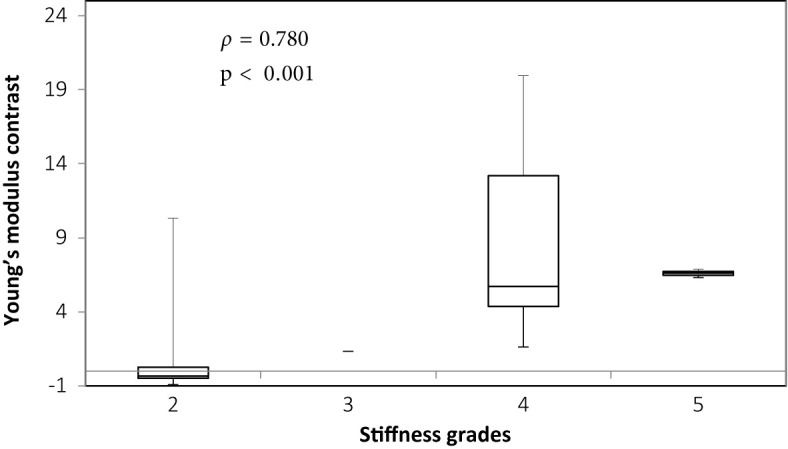
Box and whiskers plot for Young’s modulus contrast according to stiffness grade assessed by independent surgical opinion (n = 32). The upper and lower bounds of the box were the third and first quartiles, respectively, while the line within the box was the median. The upper and lower whiskers were maximum and minimum values, respectively.